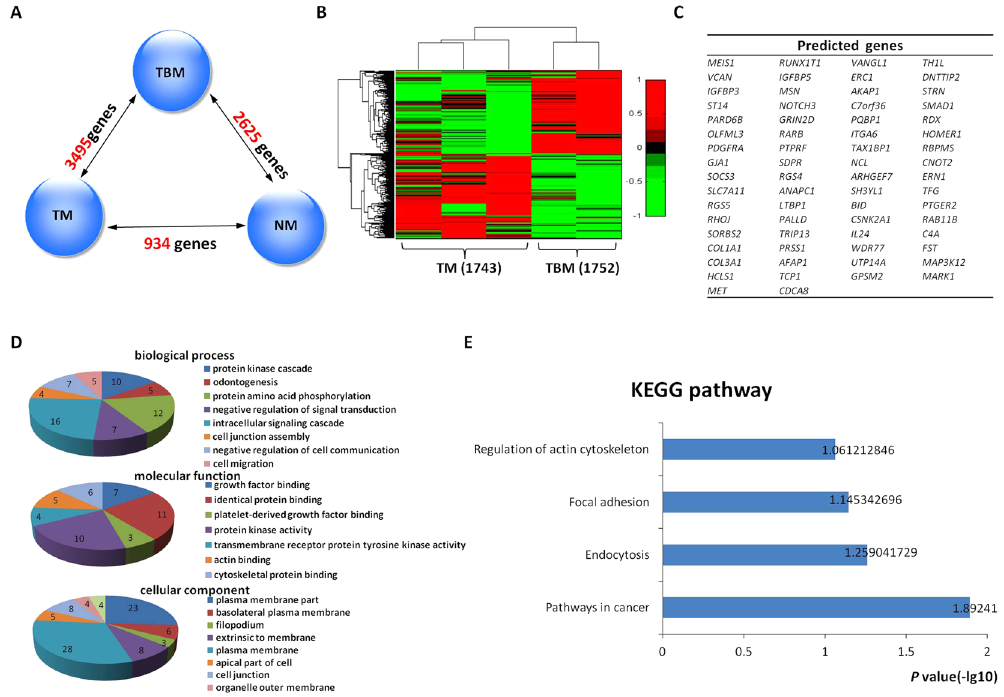
Figure 3. Selection of differentially expressed genes in the stroma cells of the tumor buds and their functional analysis. ( A , B ) Differentially expressed genes in each pair of the stromal components of IEC (NM), CCPT (TM) and tumor buds (TBM). The 3,495 differentially expressed genes were selected from TBM, including 1,752 upregulated genes and 1,743 downregulated genes, and are shown in the clustering analysis based on gene- expression levels (fold change > 2 & < 0.5).( C , D and E ) Sixty-six genes were revealed through our